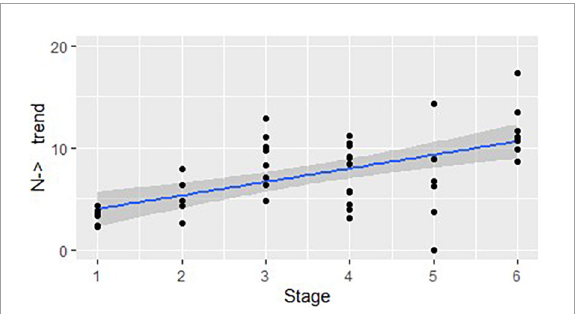
FIGURE1 The developmental trend in structures that start as a noun and change their class: correlation between the stages of linguistic development and the mean number of structures used in each DCP (represented by dots), per 100 utterances.